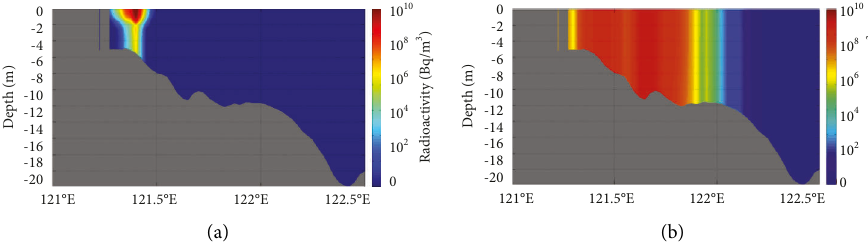
Figure 4: Vertical diffusion of 137 Cs in two weeks of summer. (a) The 11th day in summer. (b) The 14th day in summer